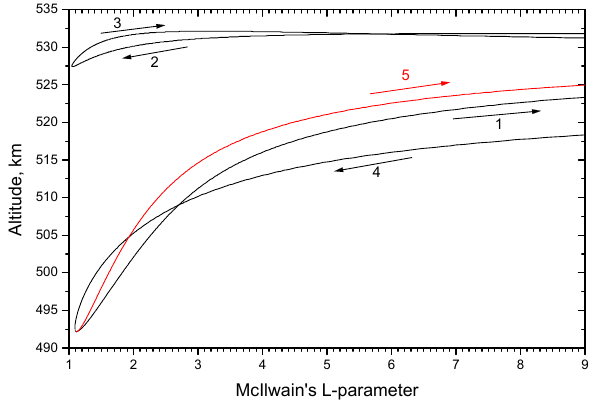
Fig. 6. The altitude of the CORONAS-I vs. L -shell parameter illus- trates the satellite altitude variation for a single orbit on day 25 June 1994 (black line). The part of the next orbit is displayed by red. The direction of satellite motion is indicated by